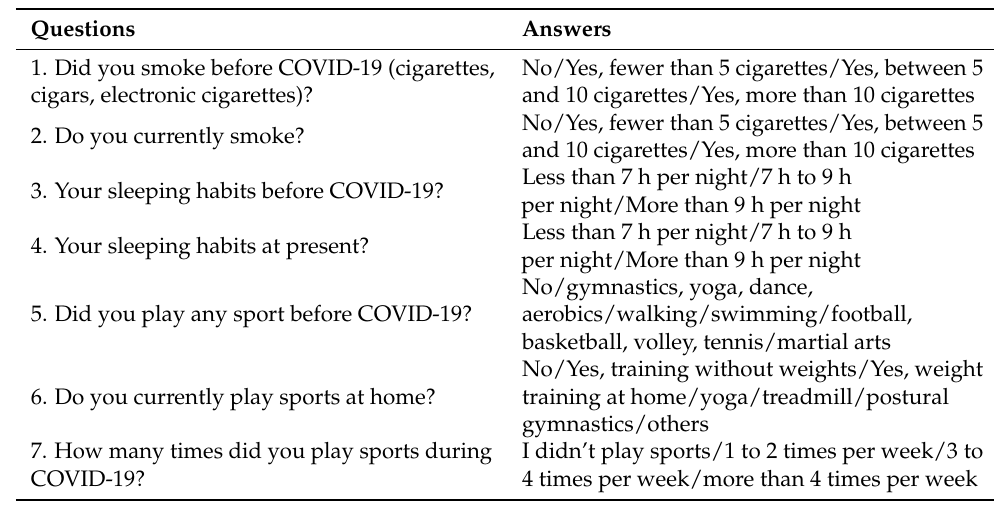
Table A5. Lifestyle habit